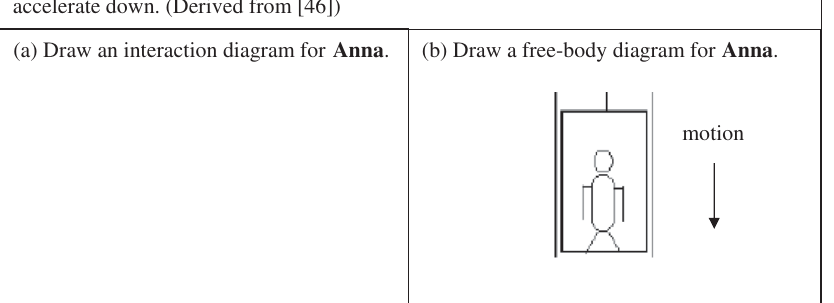
FIG. 2. Three examples on ID and FBD